Question: In one sentence, what is this figure communicating?
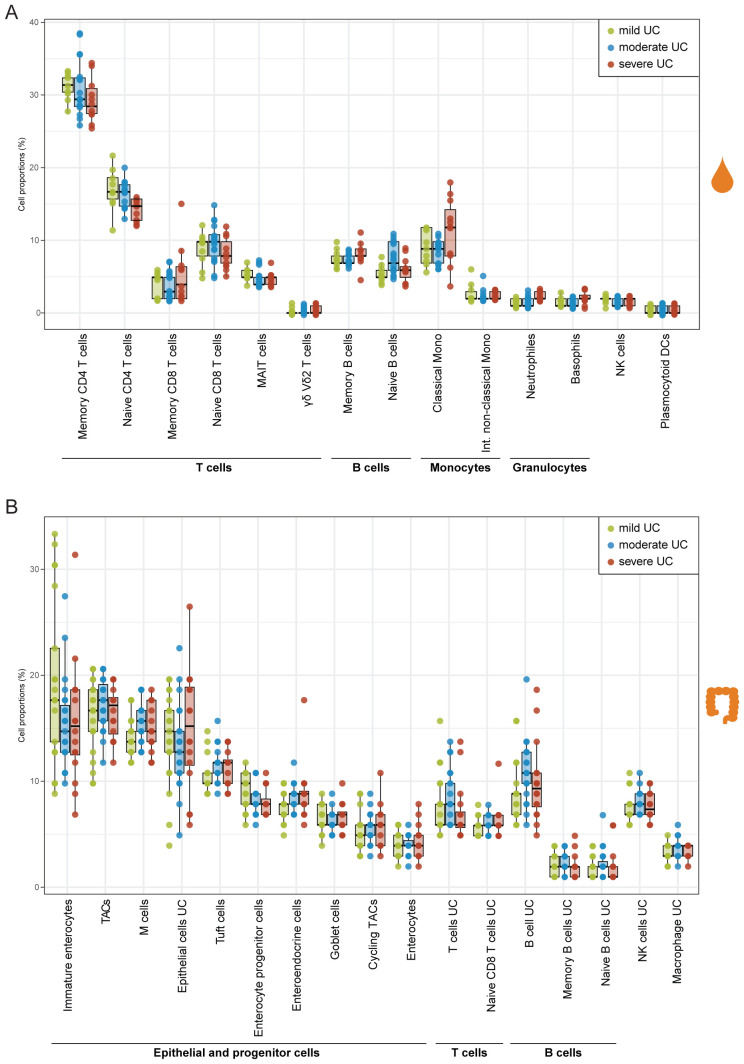
Answer: Cell type deconvolution. Computed cell proportions, in percentage, of several cell types in blood (A) and colon (B) . UC annotation accompanying several cell types deconvoluted in colon, indicates that these cell types were deconvoluted using a reference panel consisting of UC patients. Mucosal associated invariant T cells (MAIT cells), gamma delta Vd2 T cells (ϒ2 V δ2 T cells), monocytes (Mono), intermediate (Int), dendritic cells (DCs), natural killers (NK), transit amplifying cells (TACs), ulcerative colitis (UC).